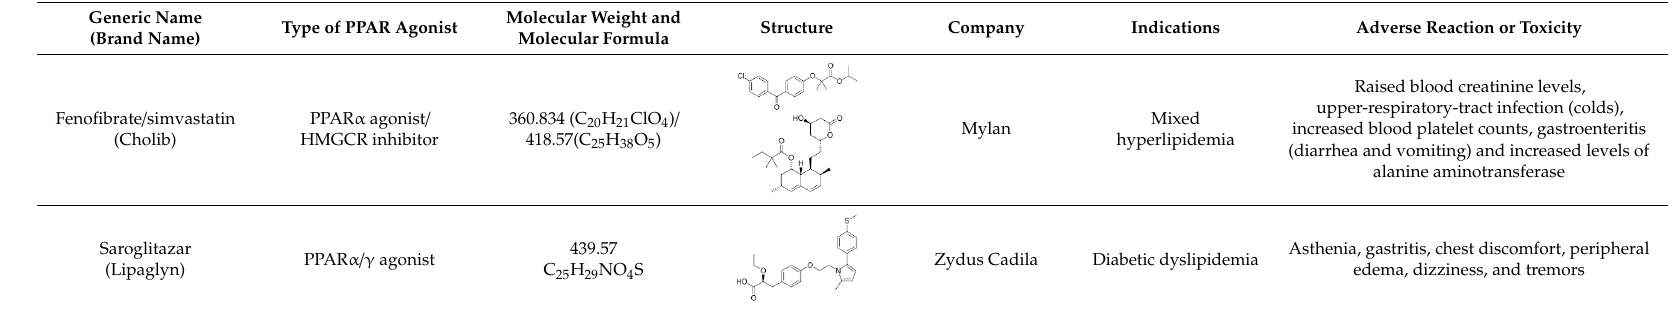
Asthenia, gastritis, chest discomfort, peripheral Zydus Cadila Diabetic dyslipidemia edema, dizziness, and tremors